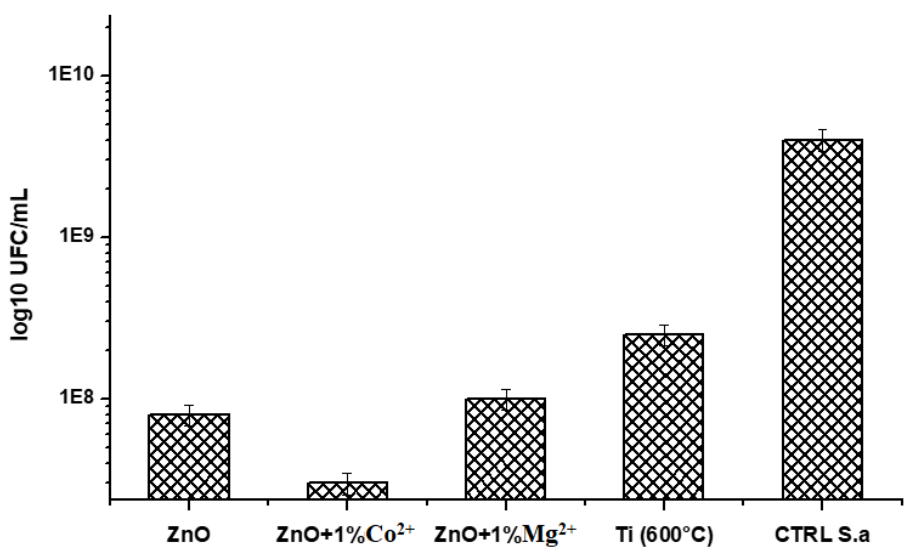
Figure 7. The Staphylococcus aureus (S. aureus) biofilm development inhibition in the presence of undoped and Co 2+ /Mg 2+ -doped ZnO film coatings on TiAlV alloy substrate.